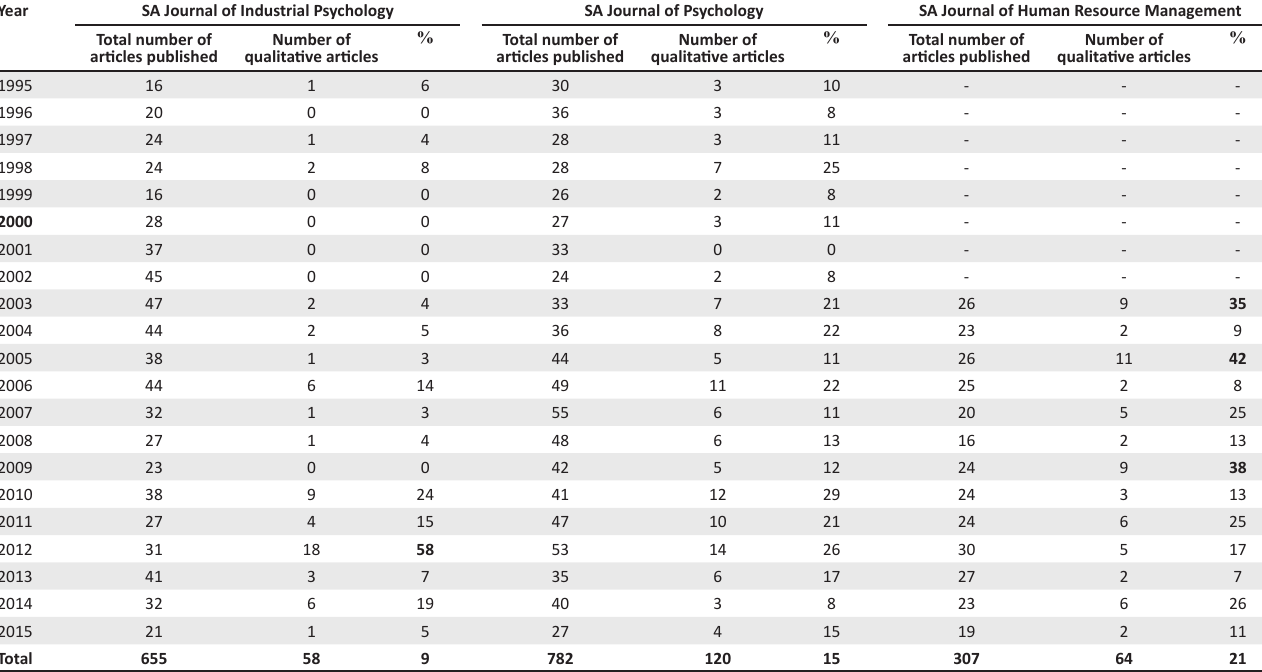
TABLE 1: Trends over the years in the number of qualitative publications per journals.